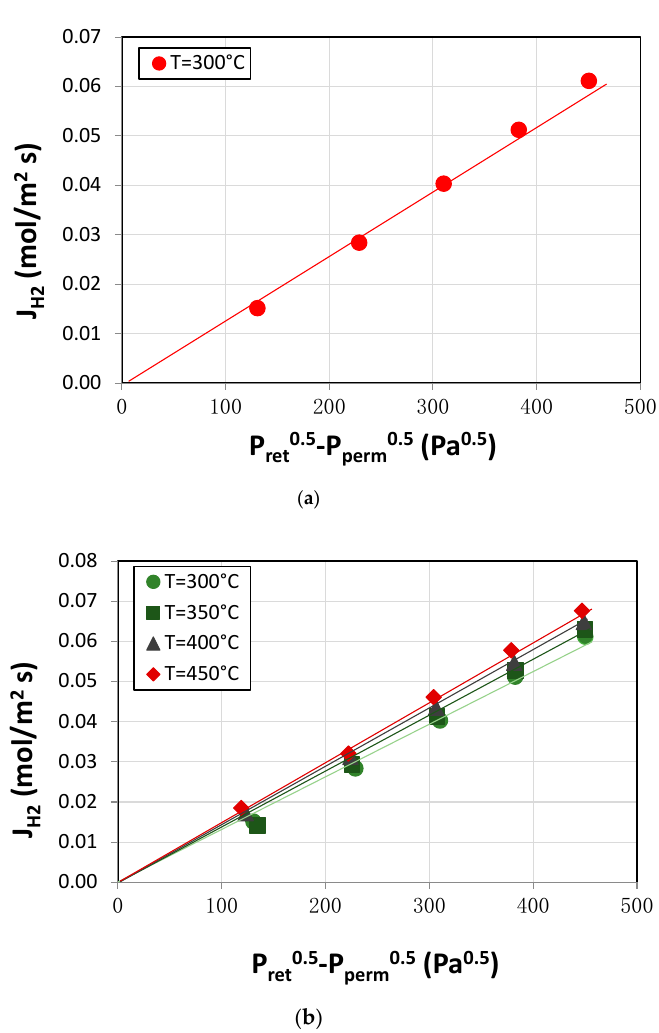
Figure 2. Effect of pressure ( a ) and temperature ( b ) in H 2 permeation tests for the finger-type PdAg membrane.